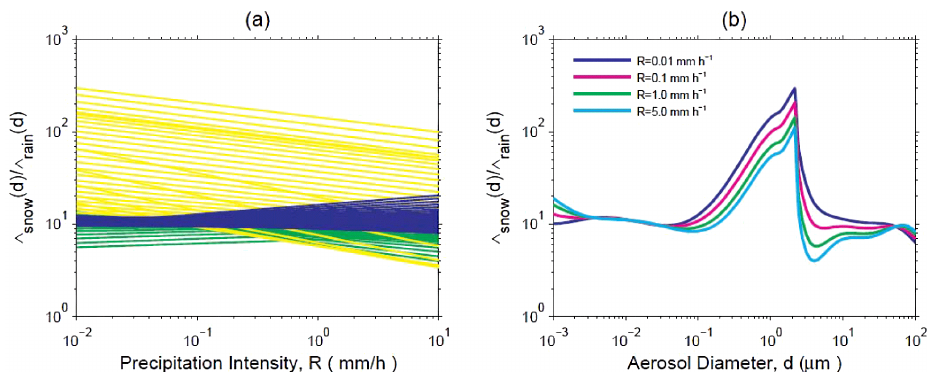
Fig. 7. (a) The ratio of parameterized 3 snow – 3 rain as a function of precipitation intensity R (liquid water equivalent) for 100 aerosol particle diameters (100 lines in total). The groups of blue, yellow, and green lines correspond to aerosol particle diameters <0.1µm, 0.1–5.0µm, and >5.0µm, respectively; (b) the ratio of parameterized 3 snow – 3 rain as a function of aerosol particle diameter d for four selected values R